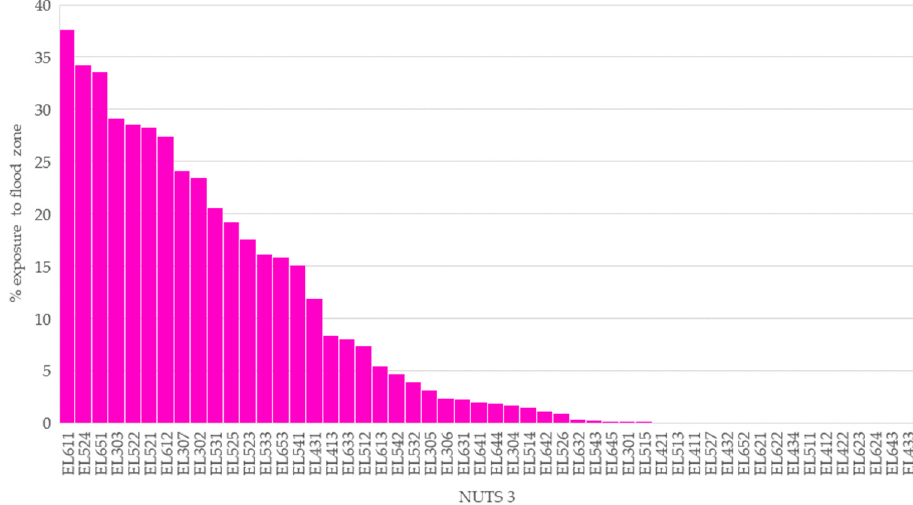
Figure 7. Graphical representation of the ratio of industrial and commercial units in flood zones per NUTS 3 in descending order.